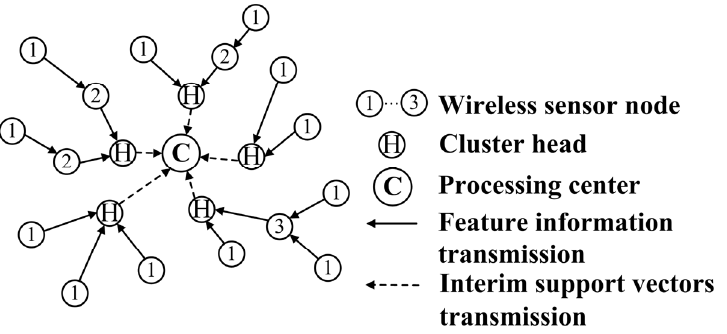
Figure 2. Computing scenario of D-C/S learning paradigm.